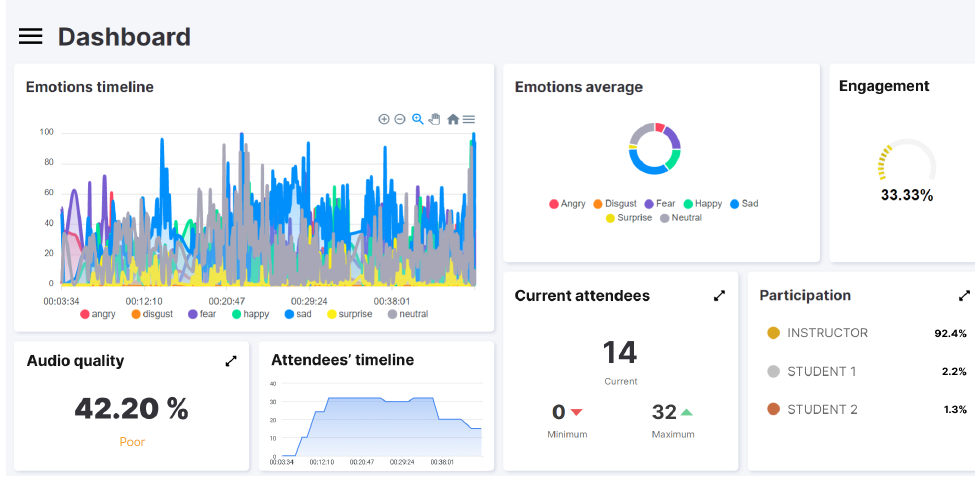
Figure 3. Software prototype, masterclass